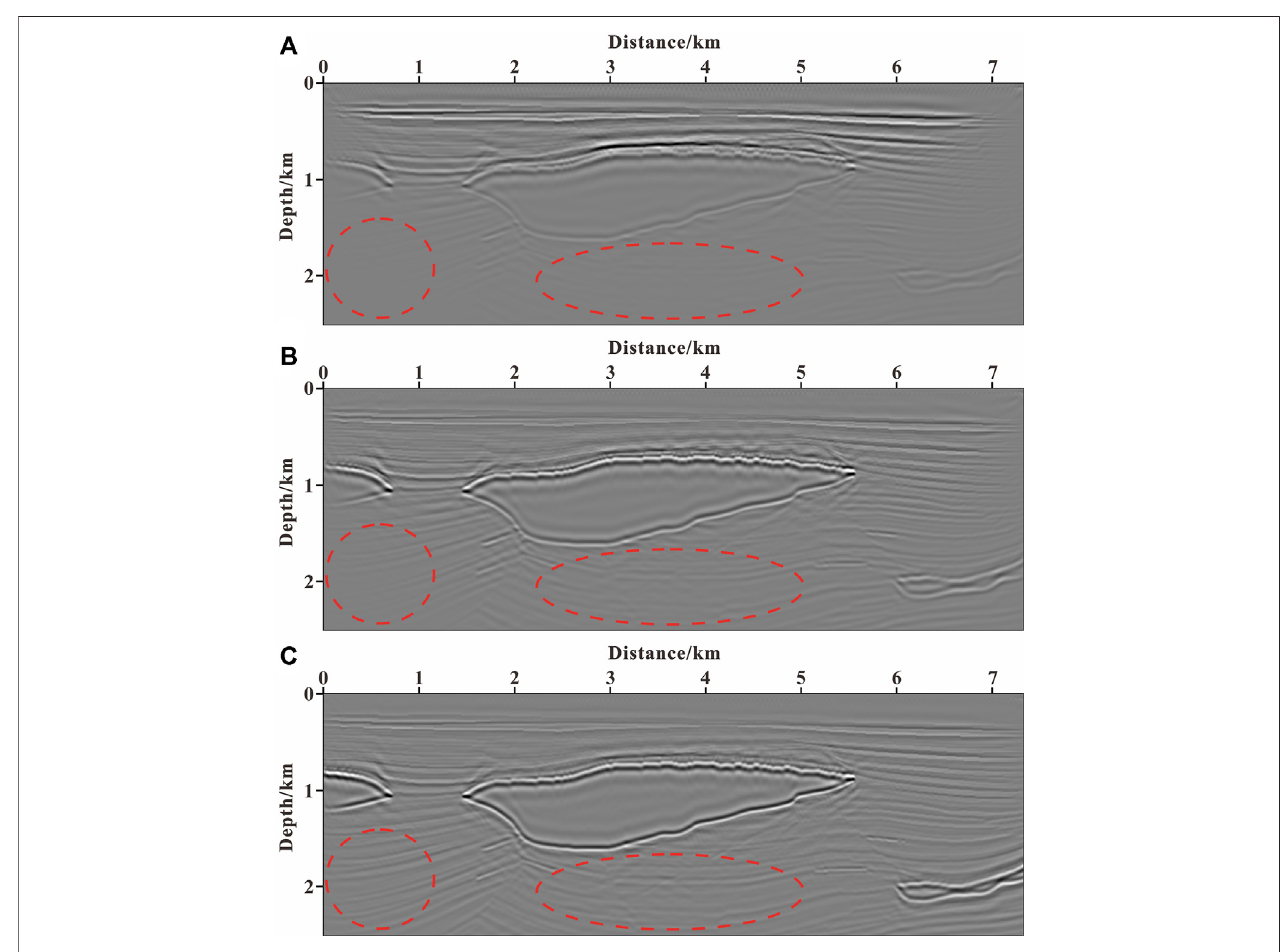
FIGURE 10 | Imaging results of LSRTM after 60 iterations: (A) without gradient preconditioning; (B) using GPSWE; and (C) using GPTWE.